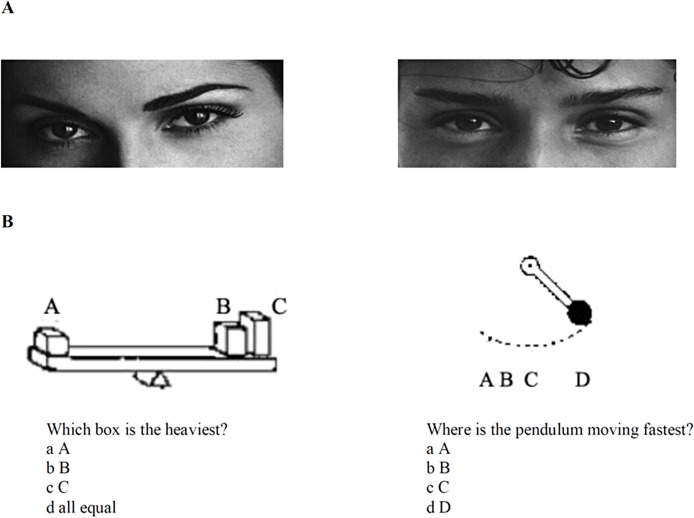
Experimental stimuli.Examples of stimuli used in the folk psychology (“theory of mind”, Eyes Test) (A) and folk physics (B) experiments (Baron-Cohen et al., 2001).